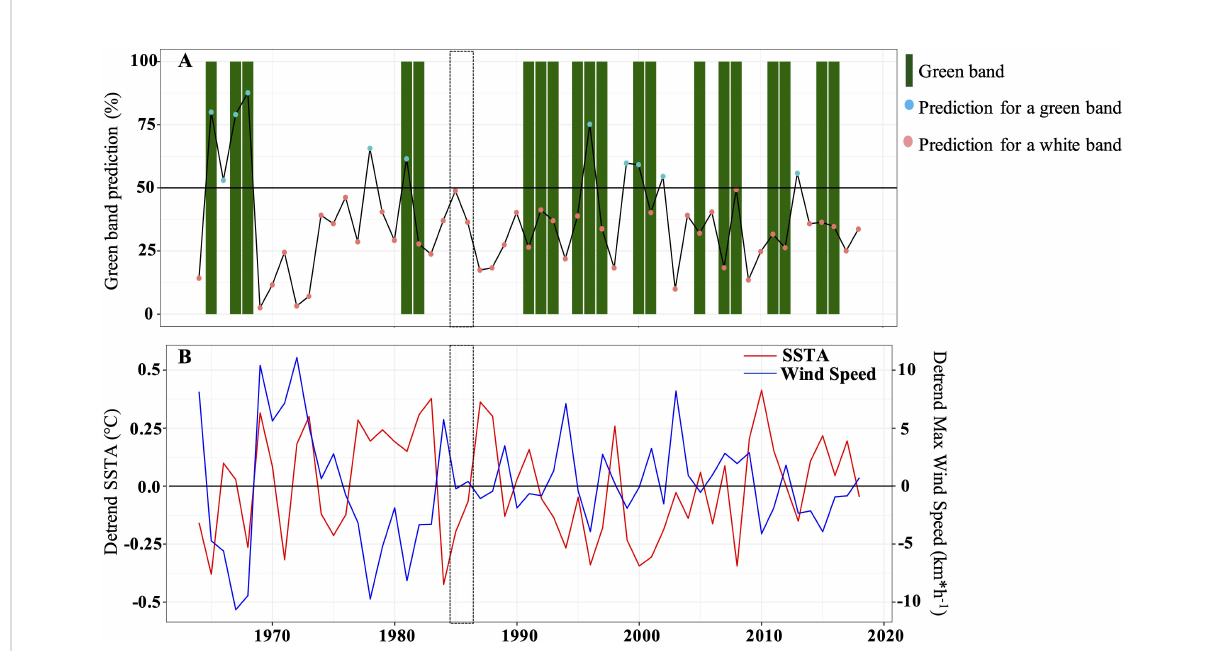
FIGURE 10 Logistic regression showing the most signi fi cant variables used in the prediction model for the presence of green bands. (A) Green band prediction model. Red dots suggest the absence of green bands while blue dots suggest the presence of green bands. Green boxes represent the different green bands observed along the coral core. The black dotted rectangle represents the breakpoint period. (B) Panel showing the most signi fi cant variables (detrended instantaneous maximum wind speed and SSTA) explaining the presence/absence of green bands. The black dotted on each panel represents the breakpoint